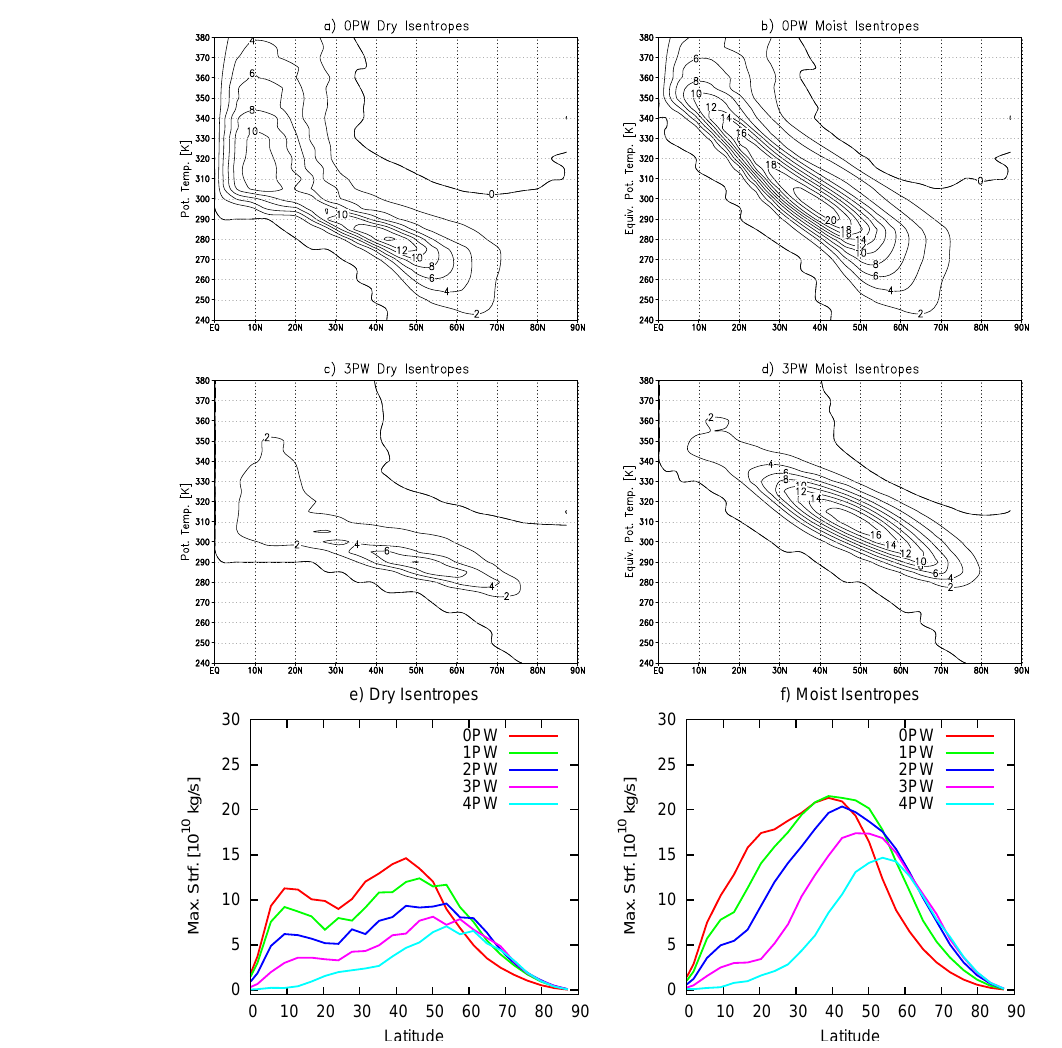
Figure 18. Upper panels: climatological annual mean mass stream function (in 10 10 kgs − 1 ) for OHT max = 0PW on (a) dry isentropes and (b) moist isentropes. Middle panels: climatological annual mean mass stream function (in 10 10 kgs − 1 ) for OHT max = 3PW on (c) dry isentropes and (d) moist isentropes. Lower panels: maximum of stream function (in 10 10 kgs − 1 ) on (e) dry isentropes and (f) moist isentropes for OHT max = 0, 1, 2, 3, and